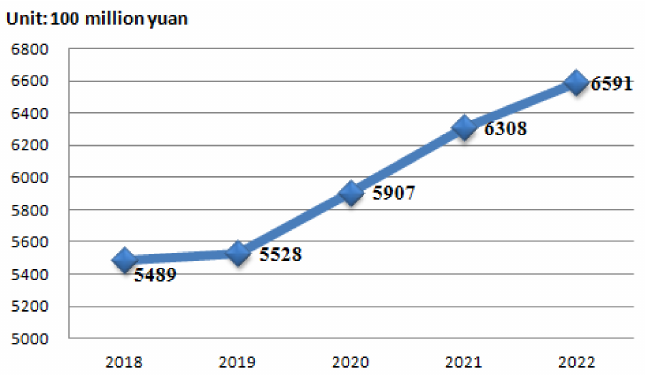
Figure 7. The forecasting results of power grid investment from 2018 to 2022 in